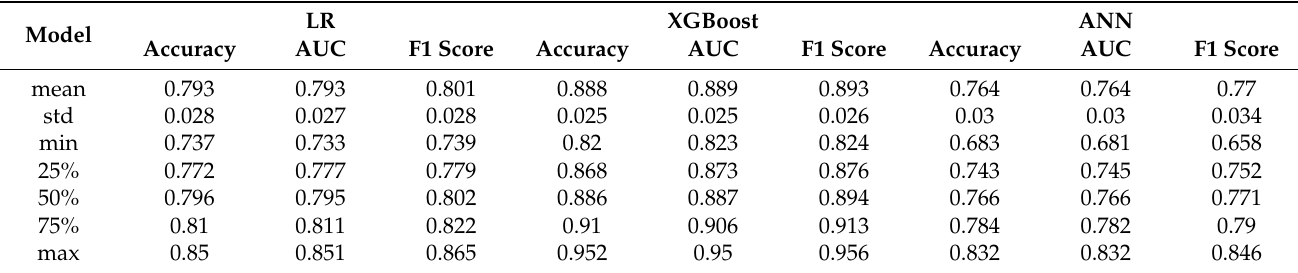
Table 4. Comparison of Machine Learning